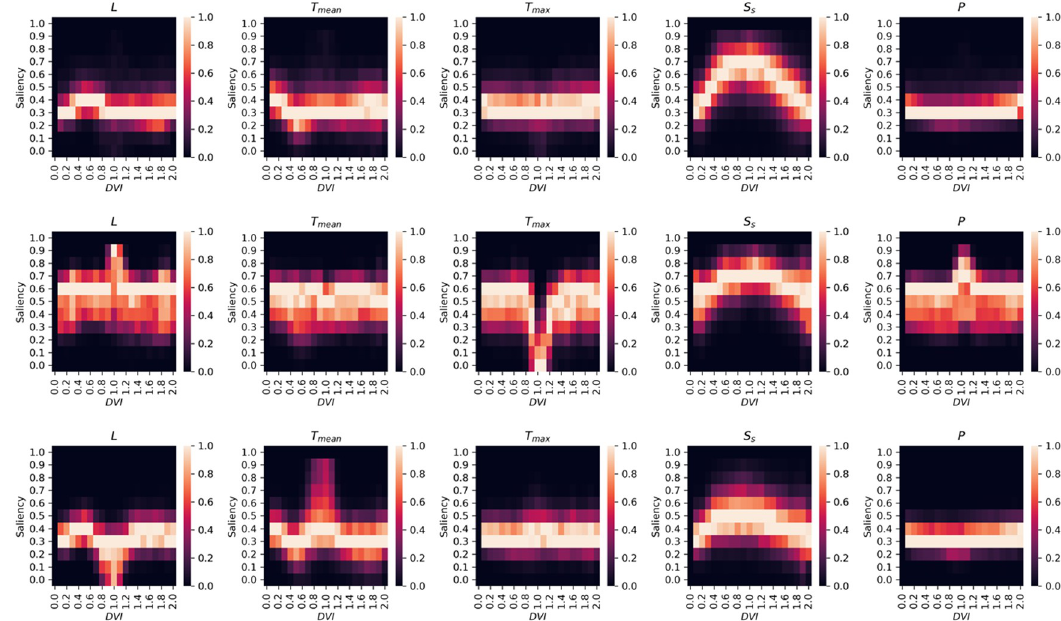
Fig 4. Positive saliencies of different meteorological elements and DV I . Saliencies were calculated from 500 datasets that were randomly selected from (top) all datasets, (middle) datasets where h